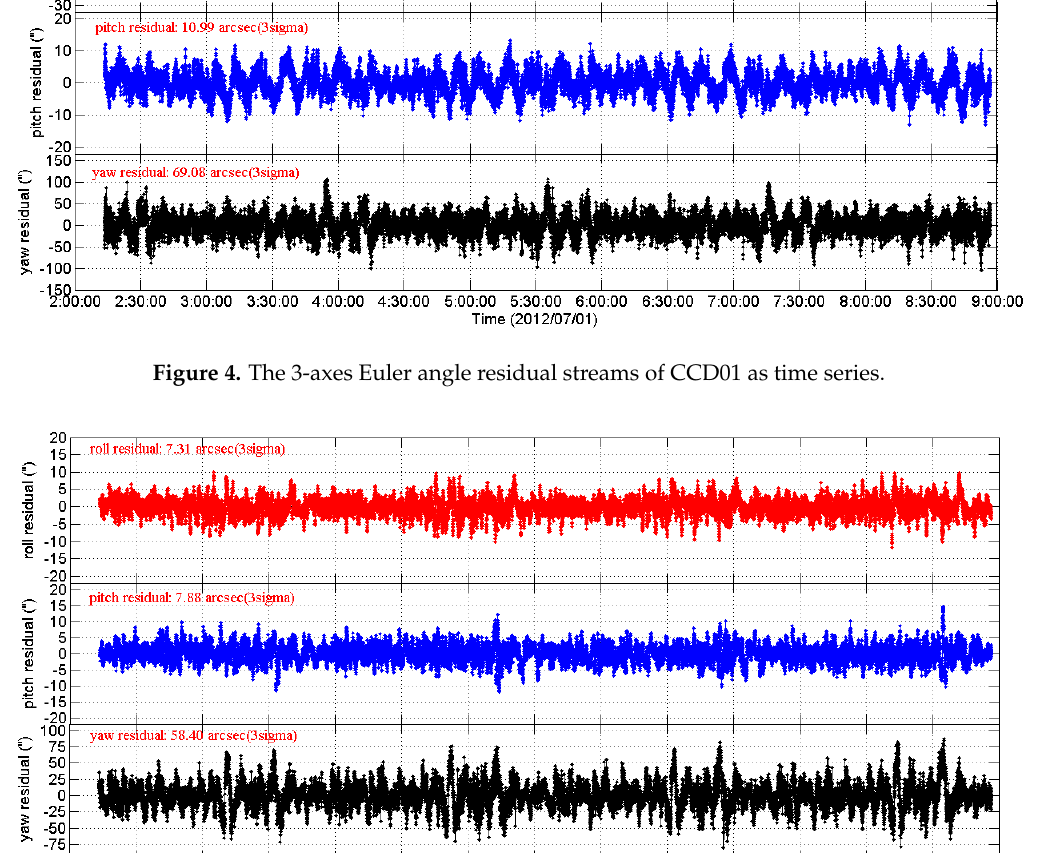
Figure 5. The 3-axes Euler angle residual streams of APS01 as time series.